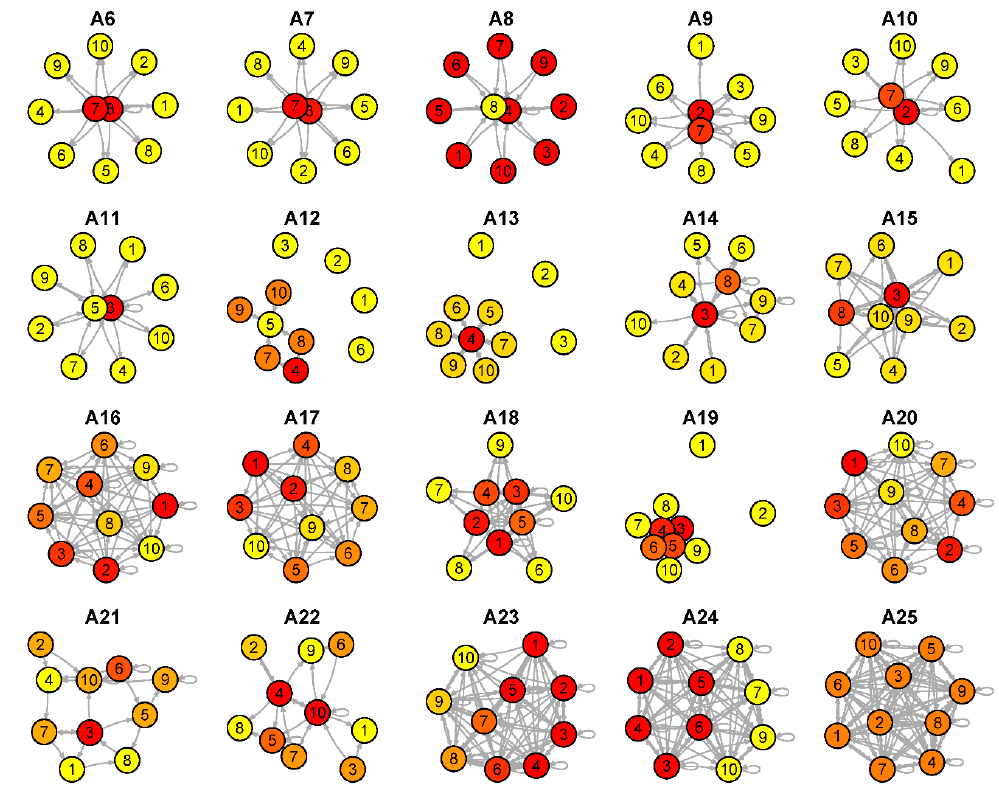
Figure A2. Graphs G ( i ) with out-degree centralities colored by the yellow-red gradient. Figure 2. Graphs G ((cid:3036)) with out-degree centralities colored by the yellow-red gradient.